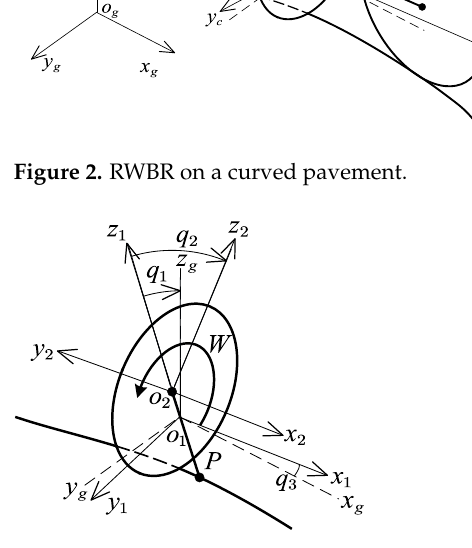
Figure 3. Equivalent inertia wheel